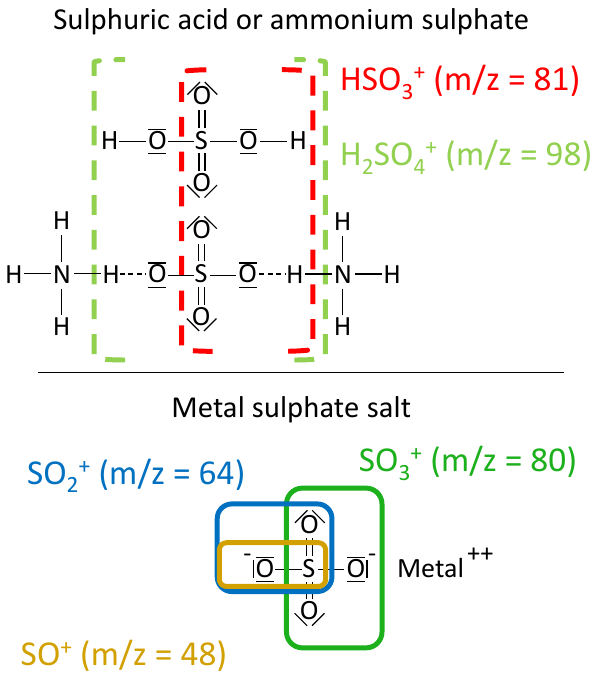
Fig. 6. Comparison between the possible fragments attributed to sulphate depending on the compound the sulphate is part of. For ammonium sulphate and sulphuric acid, hydrogen containing frag- ments are produced in the vaporisation and ionisation process while metal sulphate salts cannot produced such